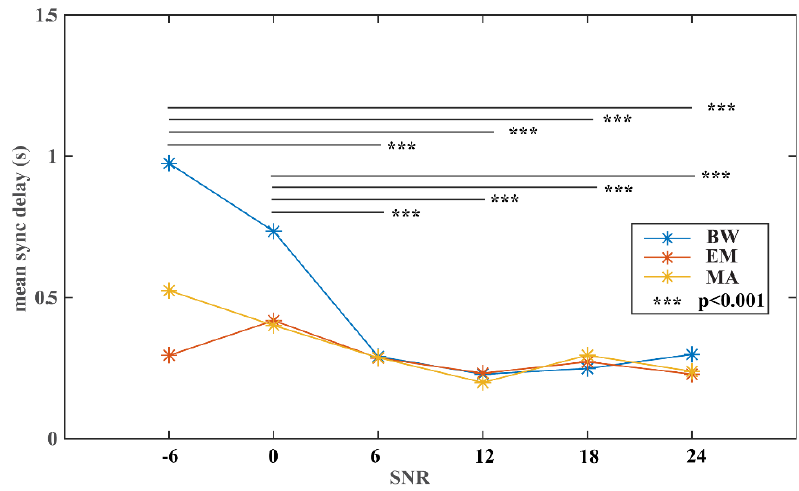
Figure 3. Time-synchronization algorithm performance with different noise types and noise levels.